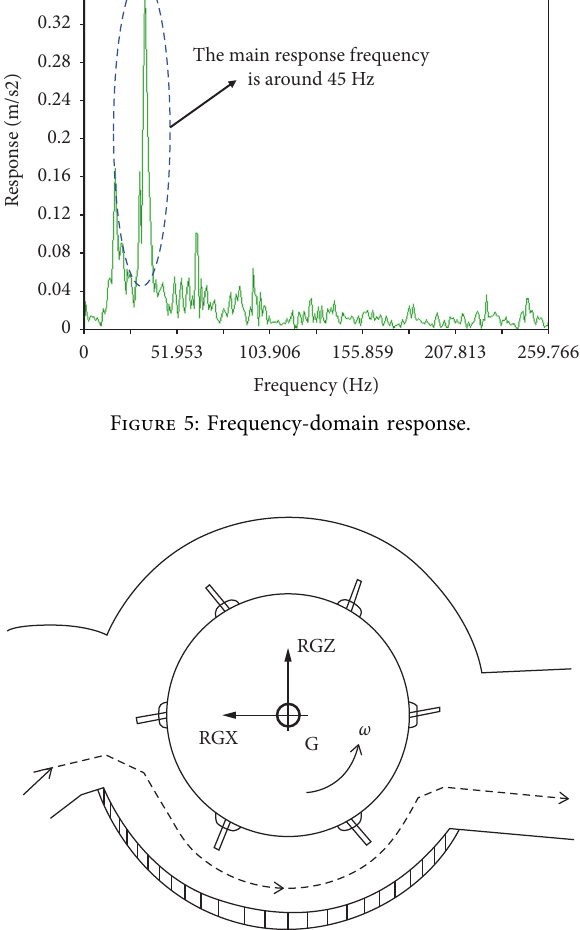
Figure 6: Unbalanced force of the threshing system.